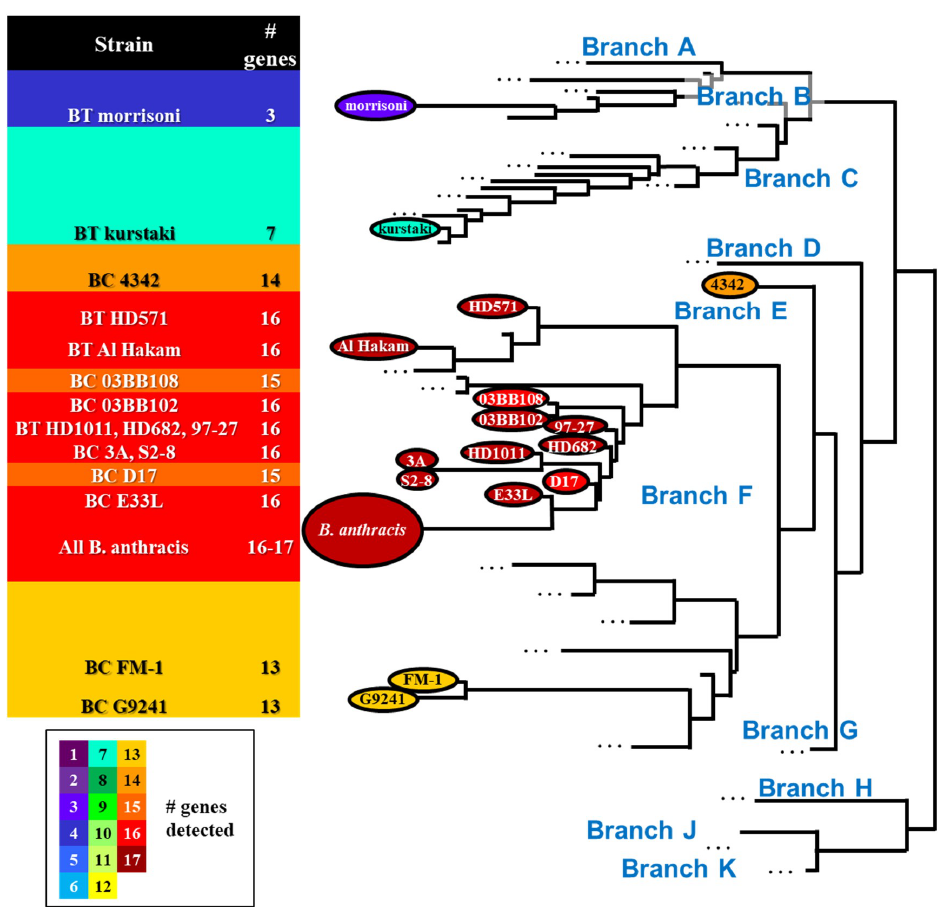
Figure 3. Phylogenetic tree of B. cereus group strains showing locations of B. anthracis , B. cereus (BC), and B. thuringiensis (BT) strains tested (tree based on [32,33]). The number of genes detected in B. cereus and B. thuringiensis strains is correlated to the phylogenetic distance from B. anthracis .